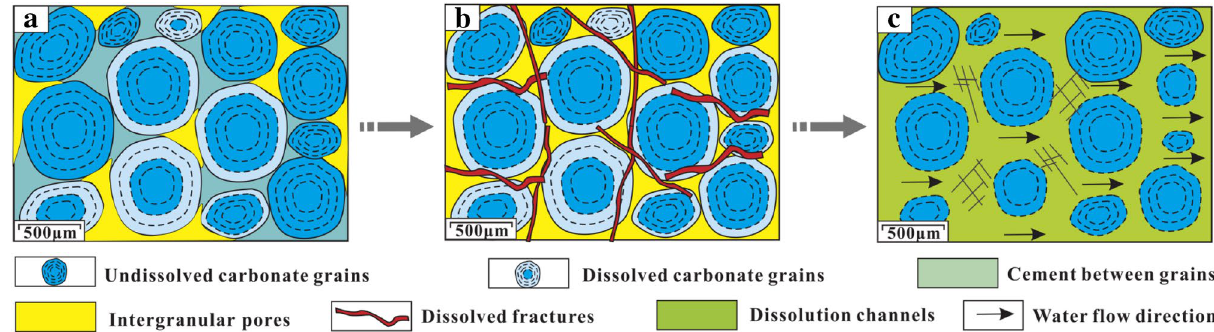
Figure 13. Development model of small dissolution channels: ( a ) Intercrystalline and intergranular dissolution pores formation; ( b ) Dissolution fractures formation; ( c ) Small dissolution channels formation.